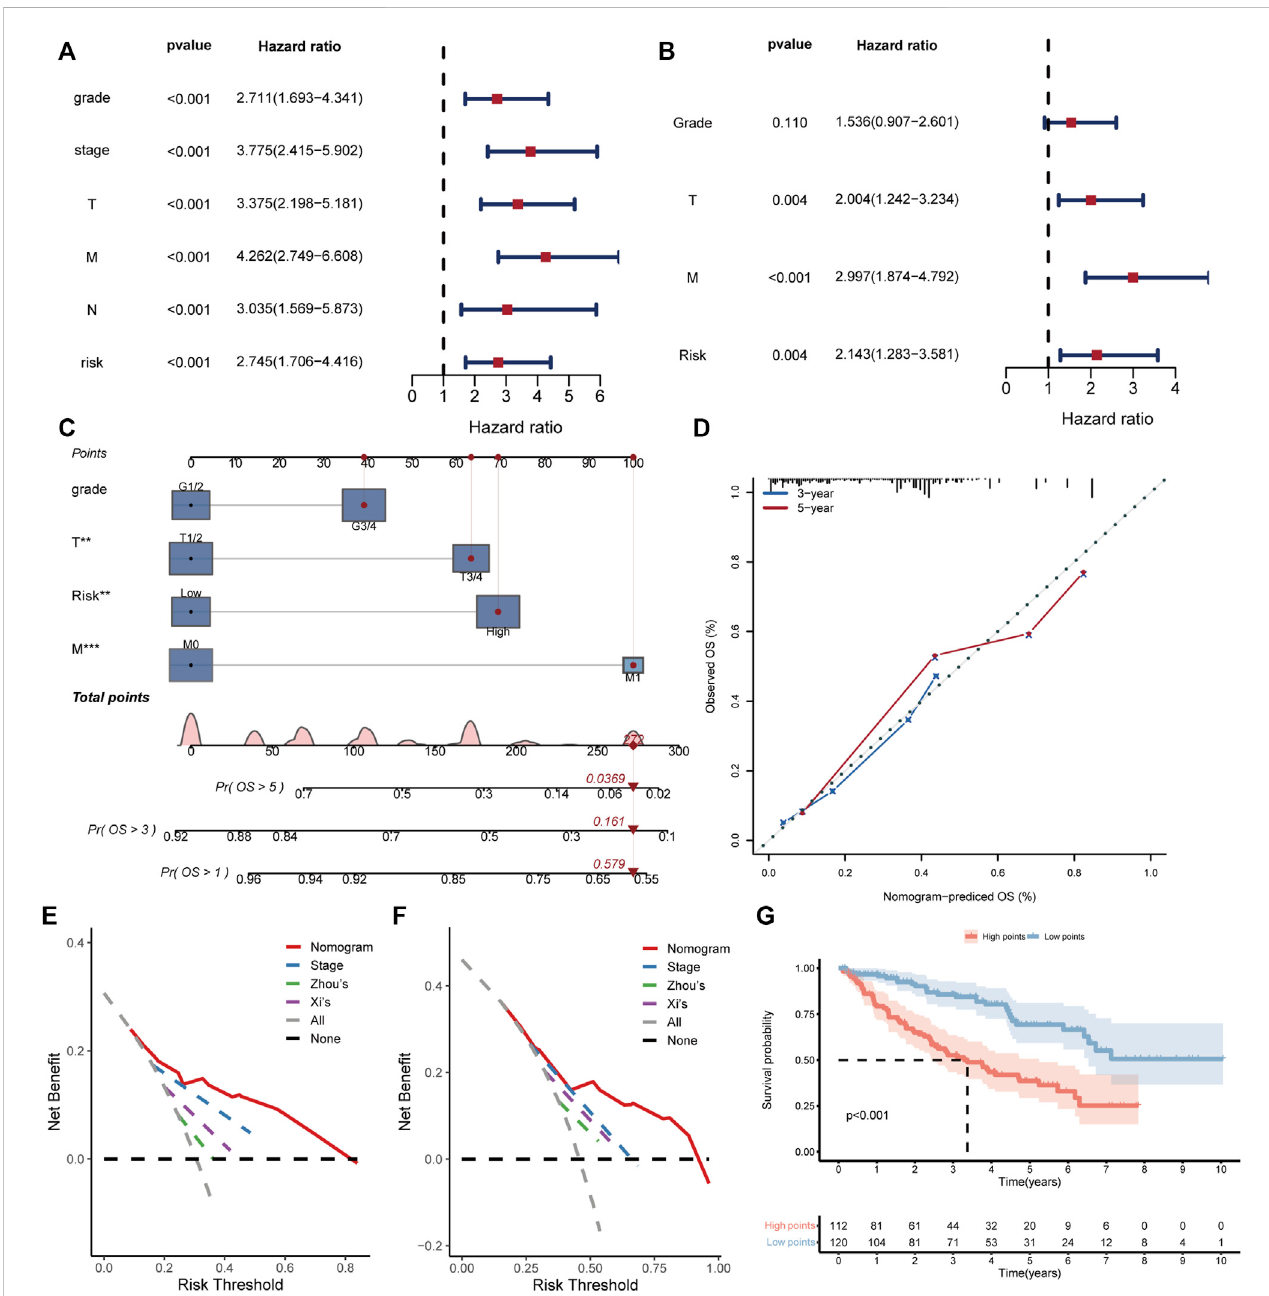
curve comparing the overall survival of ccRCC patients with high and low